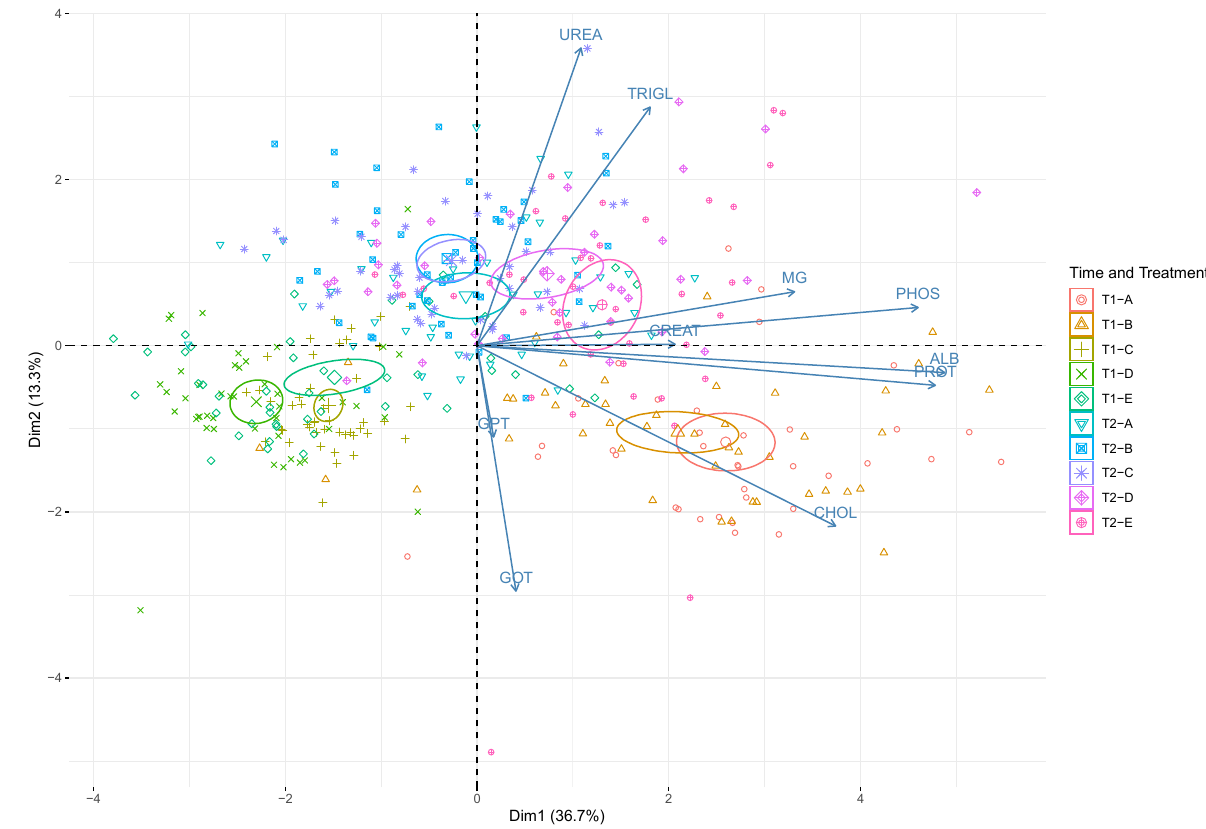
Figure 2. Principal component analysis performed on serum blood biochemical parameters in rainbow trout ( Oncorhynchus mykiss ). The scores of each time point (T1—15 days; T2—30 days) and treatment (A: control; B: 0.5%; C: 1%; D: 2%; E: 3% w / w F1-BEO) are denoted by a color and a symbol (largest symbol corresponds to average value). Confidence ellipses (95%) plot values at each sampling time point/treatment. ALB denotes albumin; CHOL cholesterol; CREA creatinine; GOT glutamic oxaloacetic transaminase; GPT glutamic pyruvic transaminase; MG magnesium; PHOS phosphorus; PROT total proteins; TRIGL triglycerides; UREA urea.